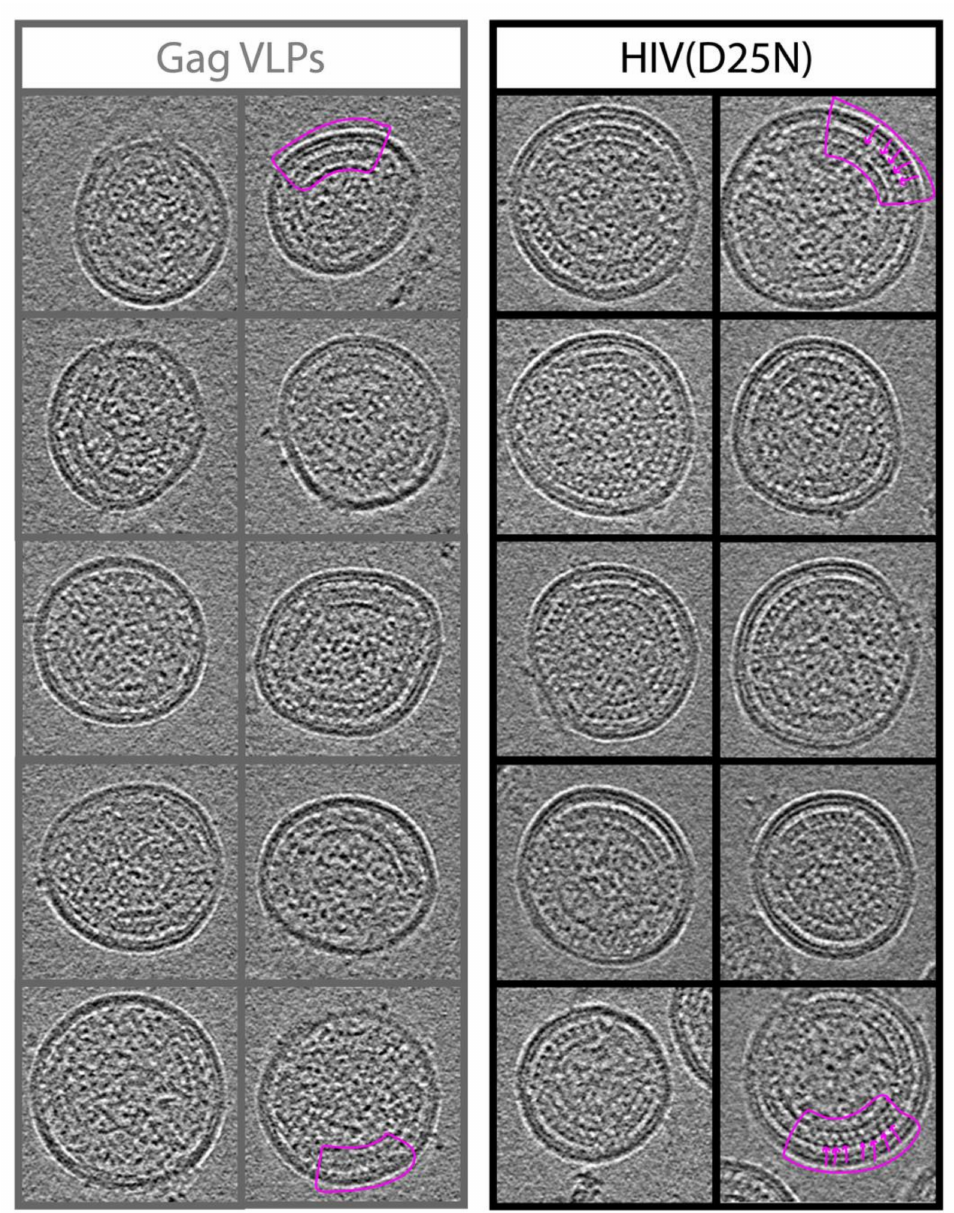
Figure 6. Cryotomography of HIV(D25N) and Gag VLPs. Mid-sections from cryotomography reconstructions are shown for 10 HIV(D25N) and Gag VLPs. In some panels, the Gag lattice is identified with the pink contour in both Gag VLPs as well as HIV (D25N) virions. Pink arrows show the striated density expected from the CA-CTD-SP1 folding which is prominent in the HIV(D25N) virions and not observed in Gag VLPs with the same